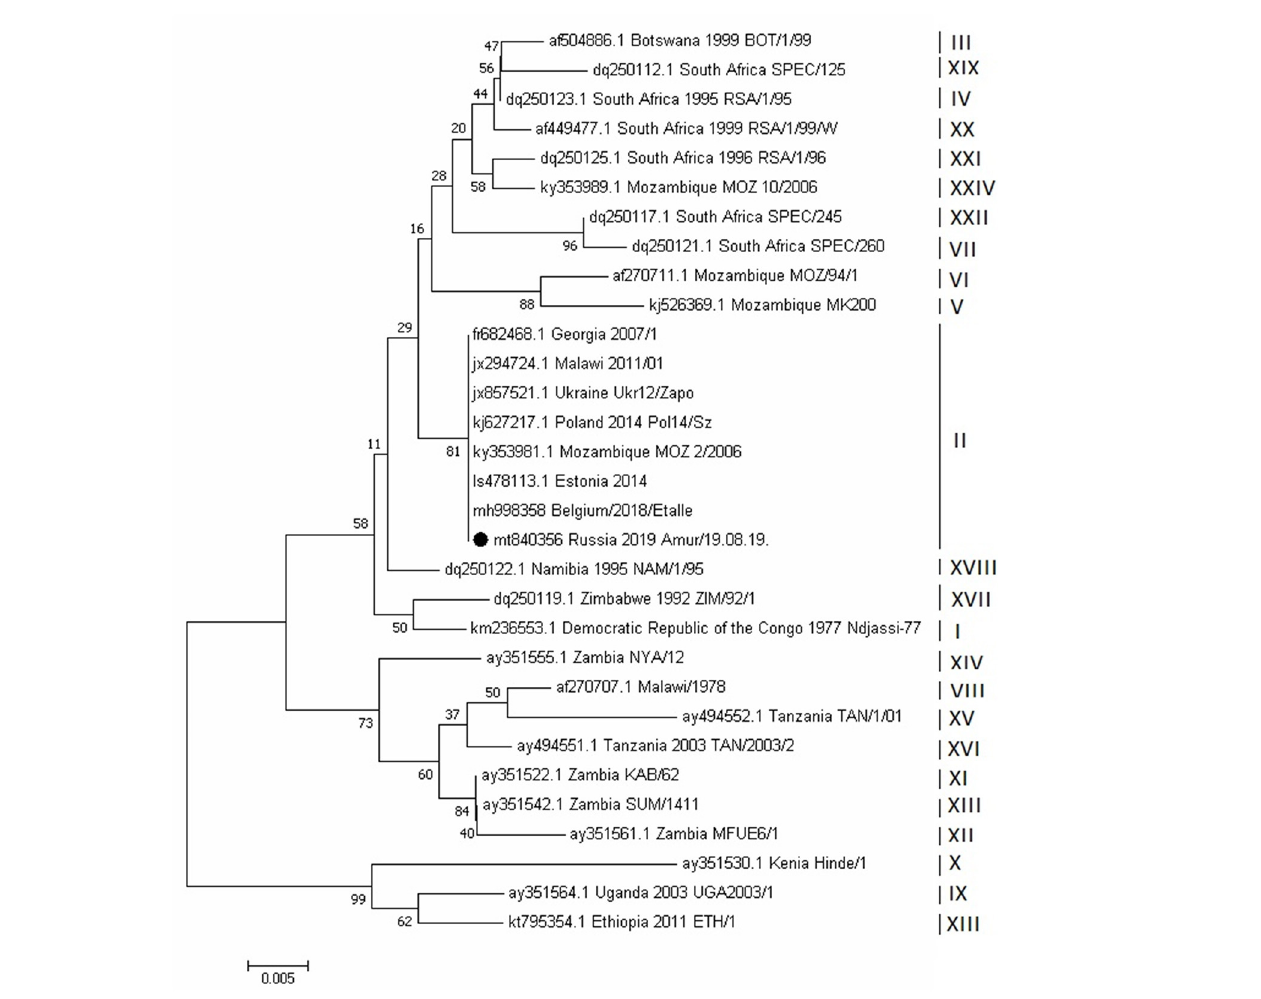
FIGURE 6 | Evolutionary relationships of African swine fever virus strains based on the neighbor-joining phylogeny of the partial p72 gene sequences. The phylogenetic analysis was performed using MEGA7. Bootstrap values (based on 1,000 replicates) for each node are given. GenBank accession numbers, country, and year of collection are indicated for each strain. Corresponding genotypes are labeled I–XXIV. The black circle indicates the African swine fever sequence from Russia, Amur region, 2019. The scale bar indicates nucleotide substitutions per site.